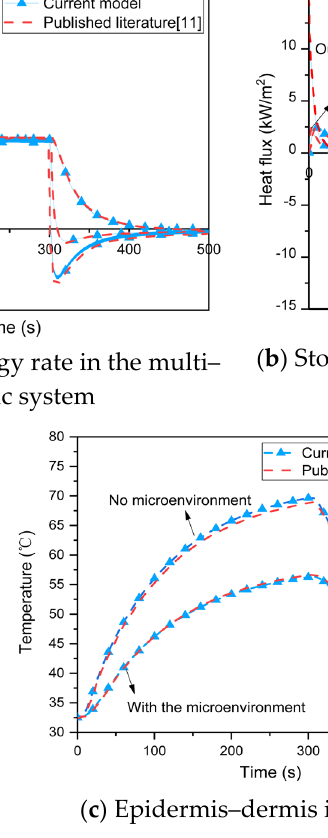
Figure 5. Comparison between the current model and the published literature [11].